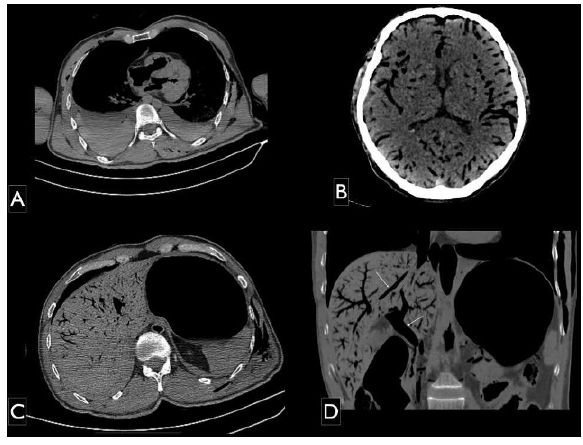
Figure 2 - PMCT images, multiplanar reconstruction axial (A and B) and coronal (C) pulmonary window. Findings in parenchymal organs: A) fluid-fluid level with higher protein decanted in the bilateral pleural space, with a larger volume on the right side; B) gas distributed in intracranial arterial and venous compartments; C) and D) intrahepatic gas in the systemic and portal venous drainage systems